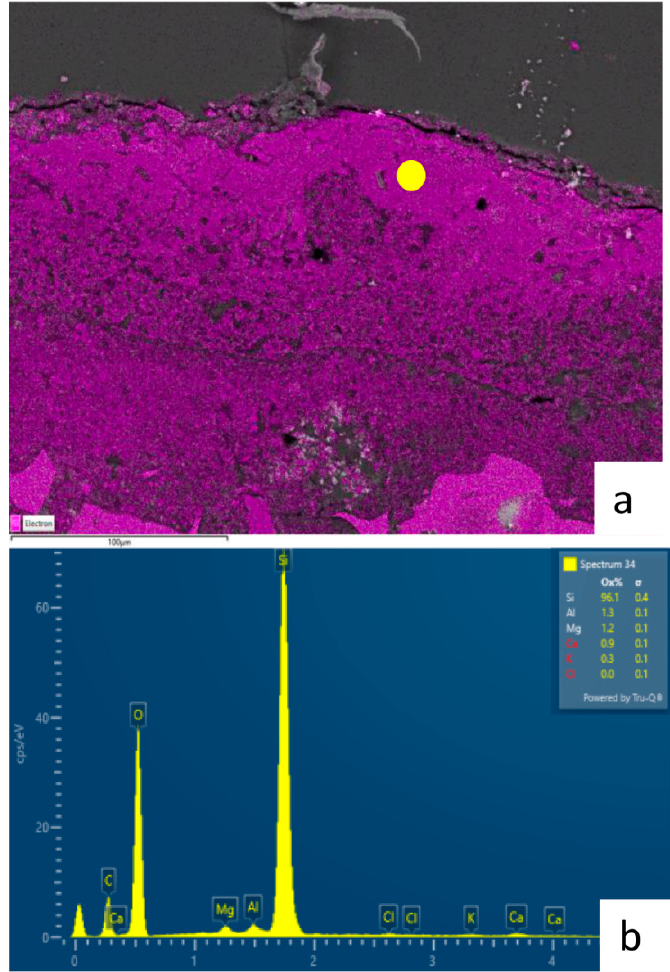
Figure 8. ( a ) Winged figure, SEM chemical map of Si (pink) of the unique white layer, the yellow dot is the point of analysis; ( b ) chemical composition inside the white layer, marked with yellow dot, visible in Figure 8a.